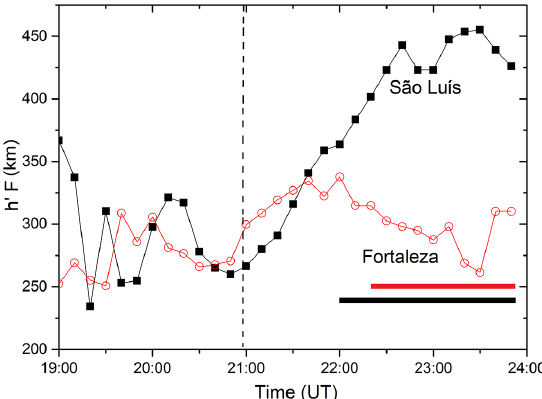
Figure 5. Upward and subsequent downward movement of the F layer observed at São Luís and Fortaleza during the flight of the rocket on 8 December 2012. The local sunset at São Luís repre- sented by the vertical dashed line. The local sunset at Fortaleza oc- curred ∼ 24min before São Luís. The red and black bars represent the range of time during which a spread F condition was observed in the ionograms taken at the Fortaleza and São Luís stations, re-